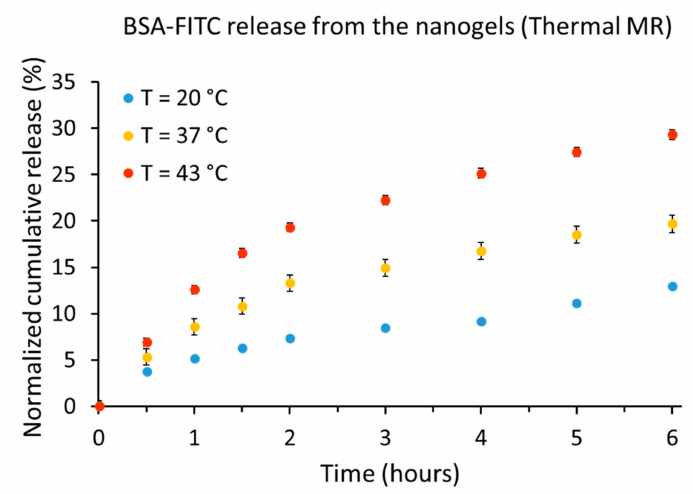
Figure 5. Bovine serum albumin labeled with fluorescein (BSA-FITC) released from the nanogels using RF heating within the MR system. After 6 h, 12.9%, 19.6% and 29.3% of the BSA-FITC were released from the nanogels at T = 20 ◦ C, T = 37 ◦ C, and T = 43 ◦ C,